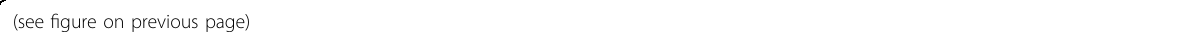
Fig. 3 Expression of sumoylation mutants of key Sumo targets alters neurogenesis. a About 50% of neurogenesis is achieved in P19 cells after forced expression of the neurogenic factor NeuroD2 and the E12 co-factor (nD) for 72 h, in comparison with empty vector transfection ( – ), as determined in immuno fl uorescence experiments by the percentage of cells expressing the neuronal marker β III-tubulin (red) among transfected cells (green, GFP positive). Nuclei were visualized by DAPI staining (blue). Scale bar 25 µm. b Quanti fi cation of the percentage of induced neurogenesis in the presence of expressed wild-type (WT) or sumoylation mutant (KR) versions of the indicated proteins. Control corresponds to the percentage of induced neurogenesis in ( a ). Values are means ± s.d. from counting 150 cells in six separated fi elds from three independent experiments. c Expression of early ( Nes and Pax6 ) and late ( Tubb3 ) neurogenesis markers was assessed in P19 cells by quantitative PCR after 48 h of RA treatment in the absence (control, empty vector) or the presence of expressed WT or KR mutant versions of the indicated proteins. Values are means ± s.d. from three independent experiments analyzed in triplicate. Statistical signi fi cance in relation to the control is indicated on top of each bar and other comparisons are indicated with a line. Statistical signi fi cance was determined by the Student ’ s t test. * p < 0.05, ** p < 0.01, and *** p <